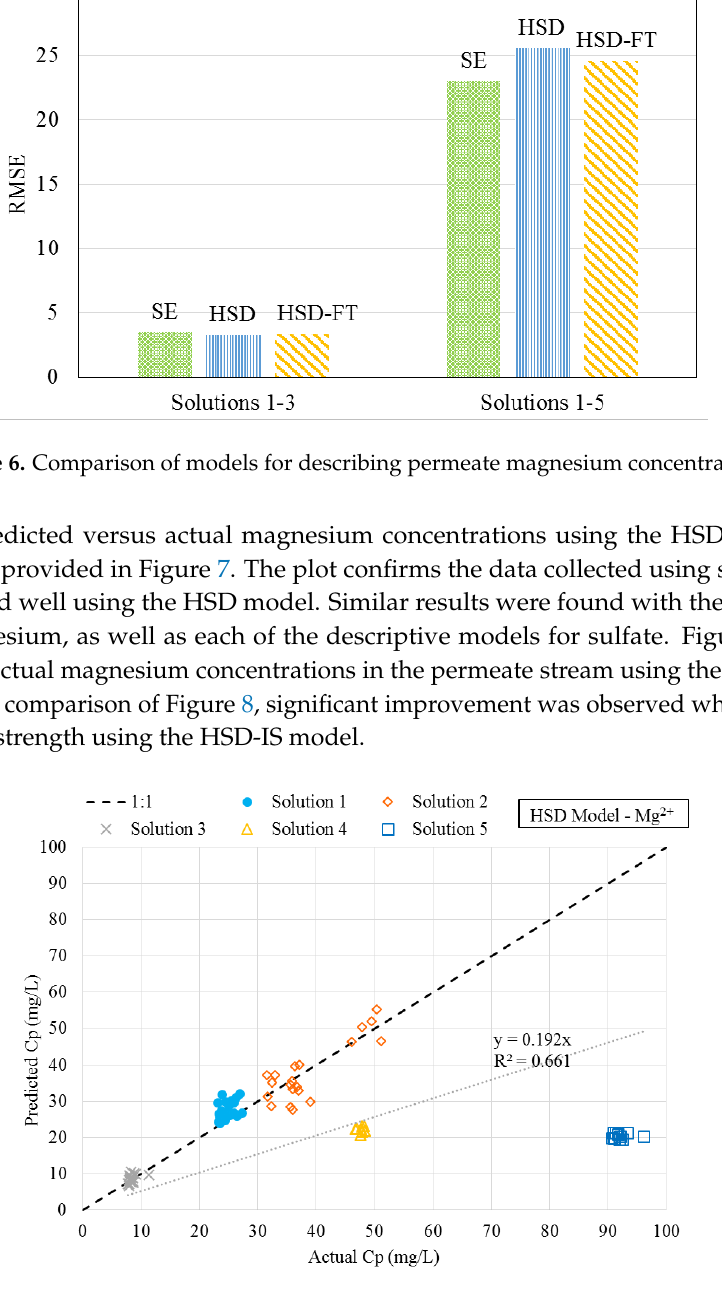
Figure 7. Predicted versus actual magnesium permeate concentrations using homogeneous solution diffusion (HSD)